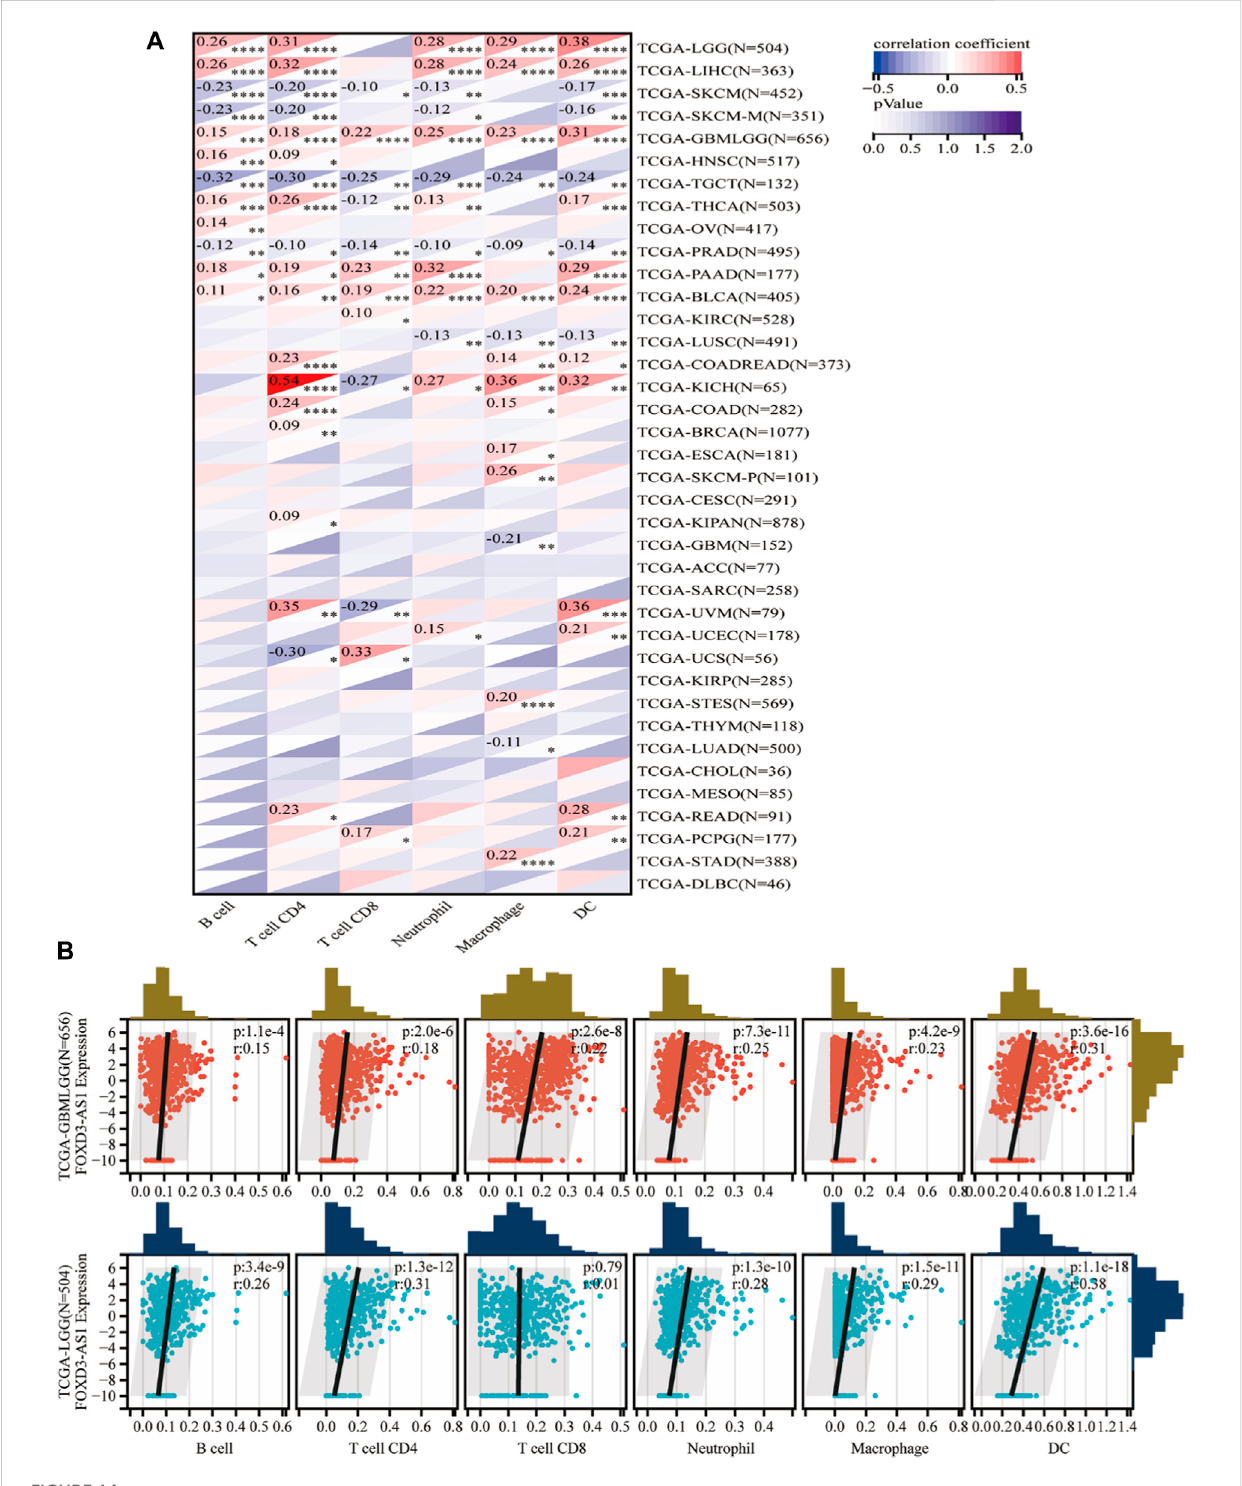
FIGURE 14 Timer database evaluation and verify. (A) The correlation between FOXD3-AS1 and B cell, T cell CD4, T cell CD8, Neutrophil, Macrophage, and DC in fi ltration scores in pan cancer; (B) Scatter plots of signi fi cant correlations between FOXD3-AS1 and B cell, T cell CD4, T cell CD8, Neutrophil, Macrophage, and DC in fi ltration scores in GBM and LGG assessed by